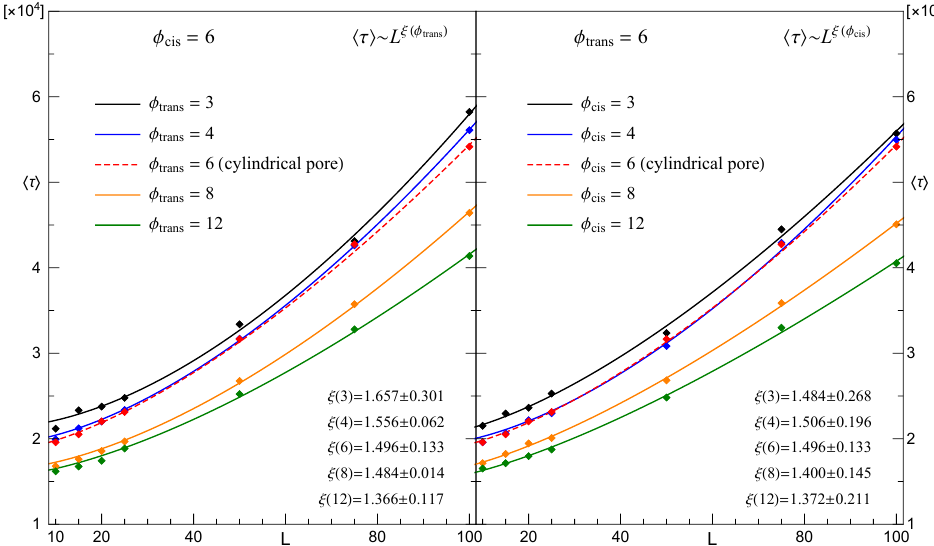
(cid:10) (cid:11) τ vs. membrane thickness L for a CLB passing through